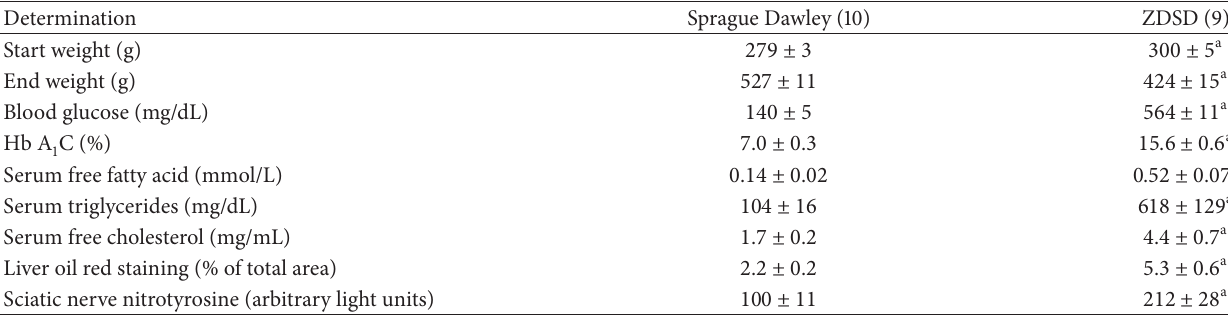
Table 1: Vital parameters for Sprague Dawley and ZDSD